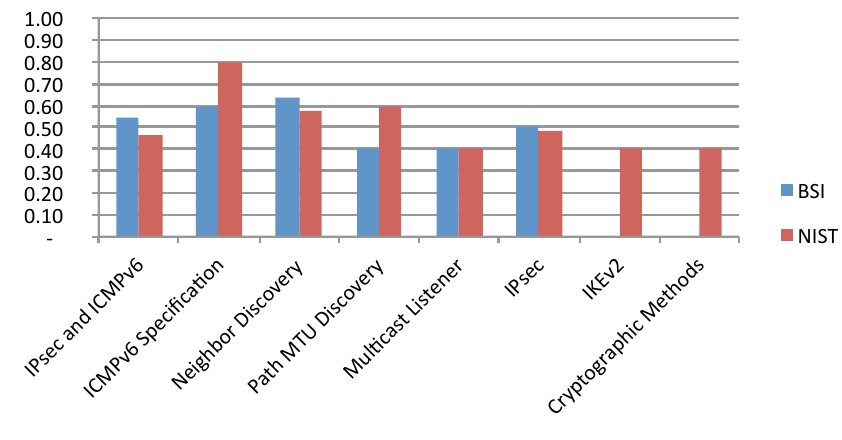
Figure 10. Average depth of IPsec and